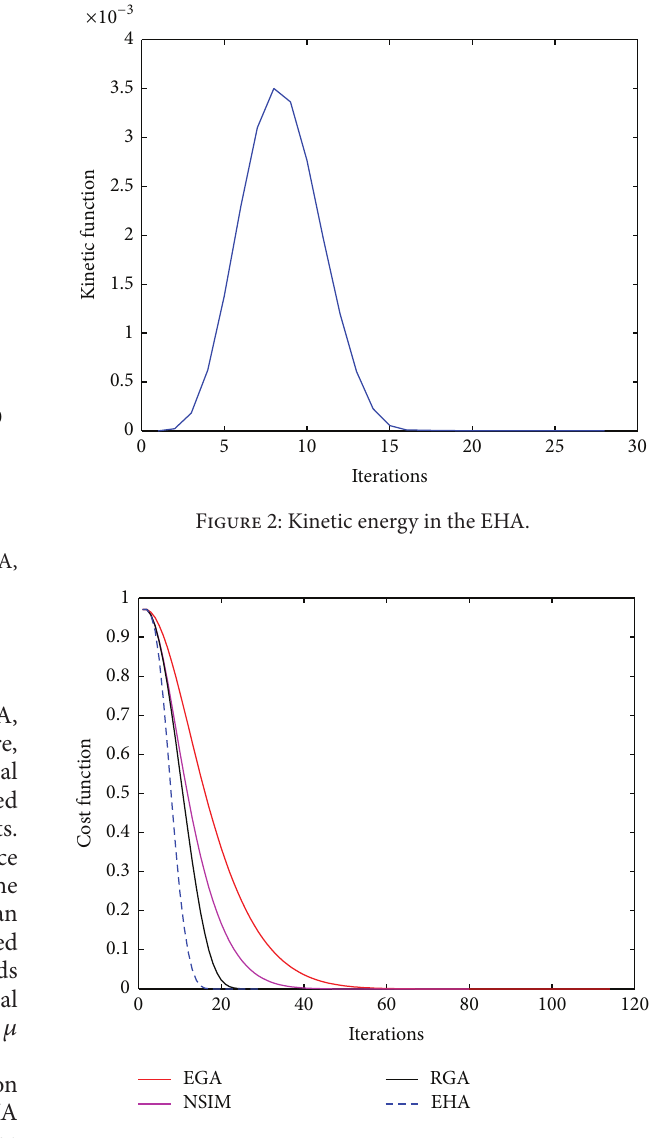
Figure 3: Comparison of convergence speeds of the EGA, the RGA, the NSIM, and the